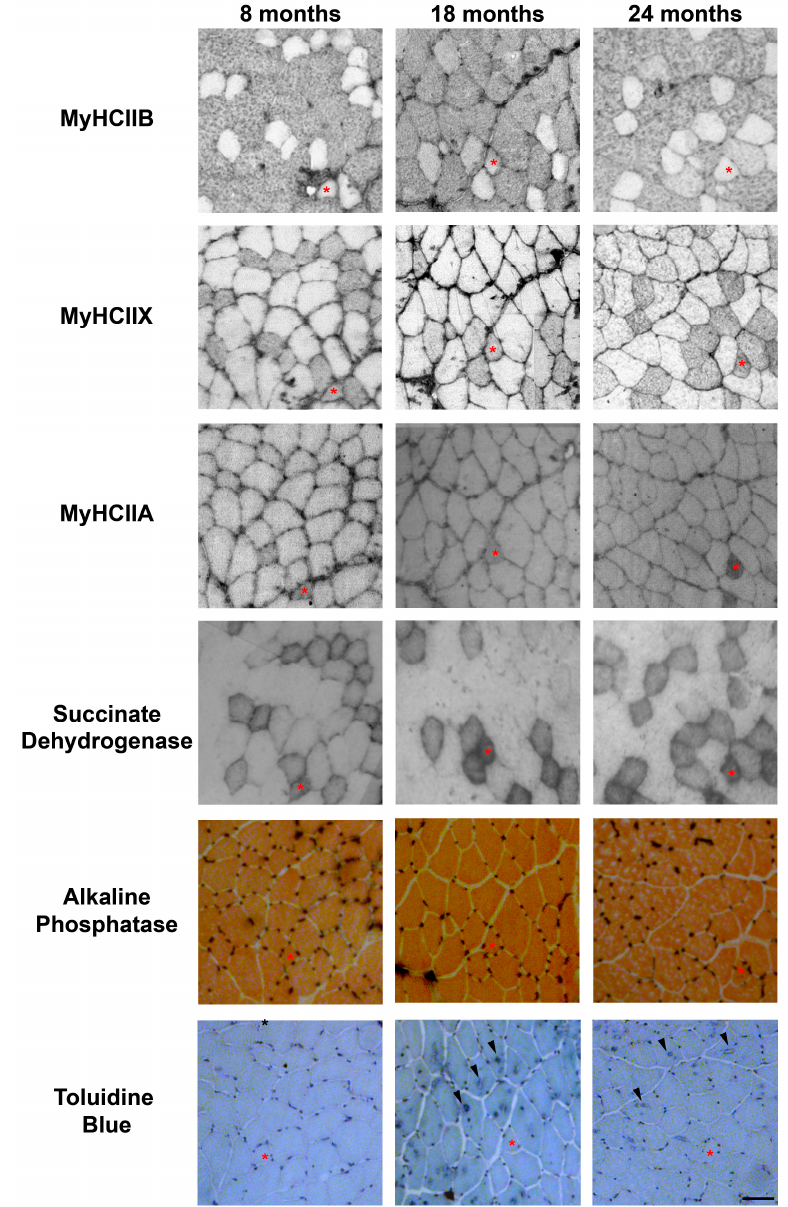
Figure 2. Representative examples of serial sections from aging tibialis anterior muscles, stained for MyHC IIB, IIX and IIA, succinate dehydrogenase, alkaline phosphatase to detect capillaries, and Toluidine Blue to evidence TAs. An asterisk indicates a IIX / IIA fiber in each section, and arrowheads point toward fibers presenting TAs. Bar 50 μ m.